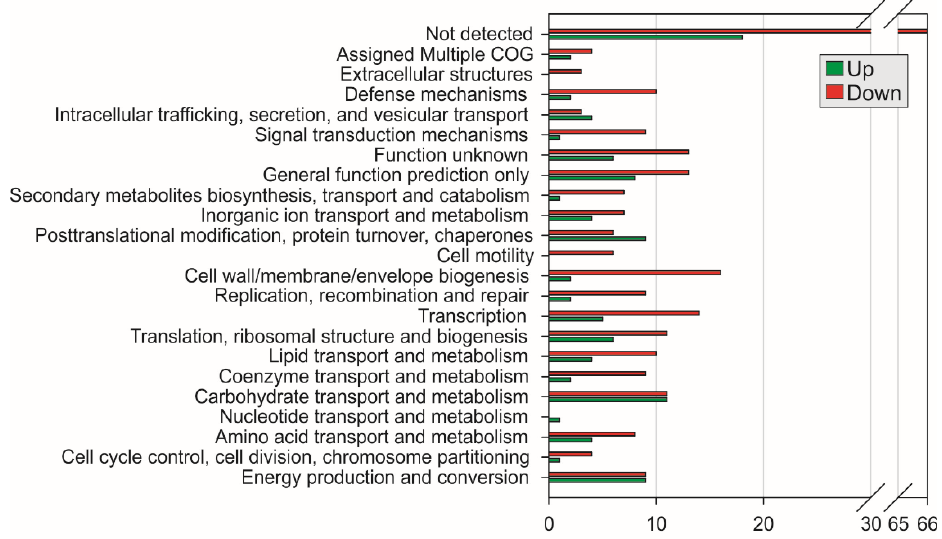
Figure 2. Functional classification of genes upregulated and downregulated in strain PAL5 grown under either iron or iron-depleted conditions. The genes were classified according to function by COG (Clusters of Orthologous Groups of proteins) (http://www.ncbi.nlm.nih.gov/COG (accessed on May 10, 2022)).